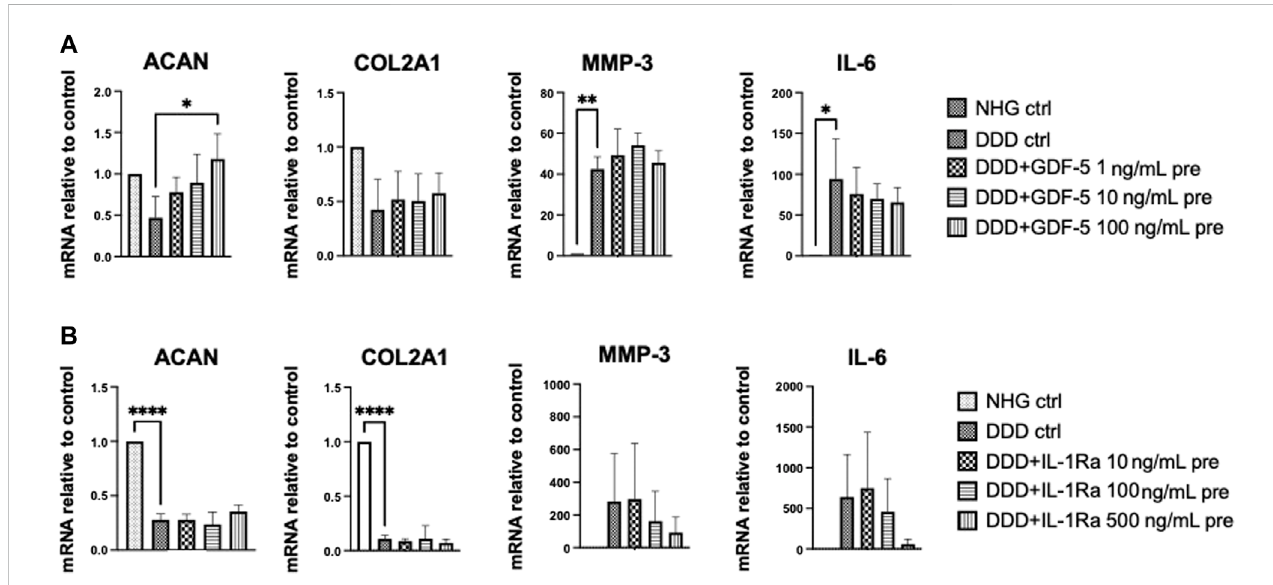
FIGURE 4 2D drug screening: Effects of drug pre-treatment on NC in DDD-mimicking conditions. Gene expression (relative to control) of anabolic genes (ACAN, COL2A1) and catabolic genes (MMP-3, IL-6) in NC pre-treated with (A) GDF-5 or (B) IL-1Ra. NHG: healthy condition, DDD: DDD mimicking condition ( n = 3, mean ± SD, * p < 0.05,